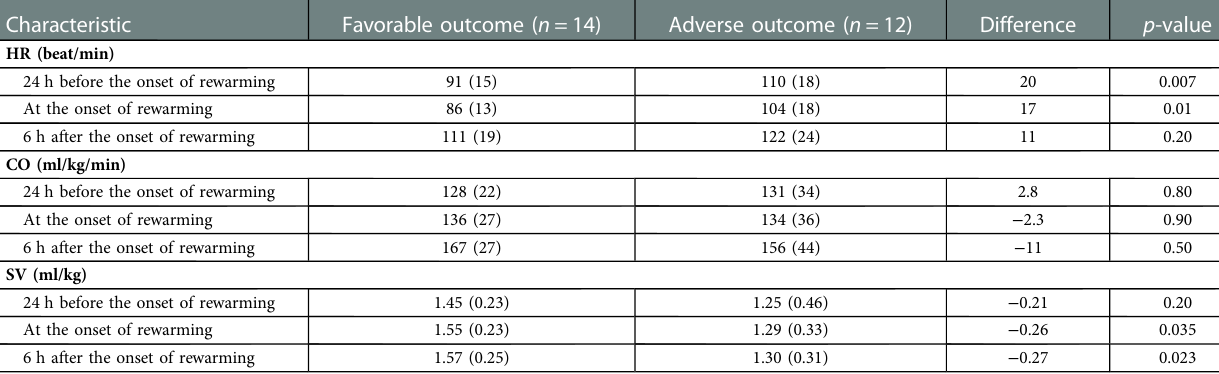
TABLE 5 Comparison of estimated values of cardiac function at − 24 h, 0 h, and 6 h.